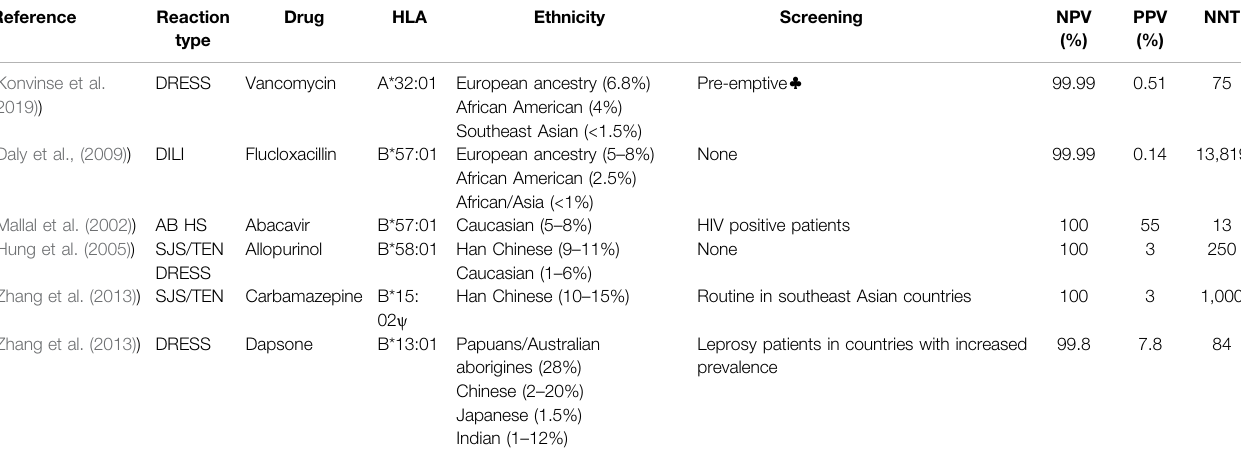
TABLE 4 | HLA associations in SCAR and DILI with possible clinical implications.